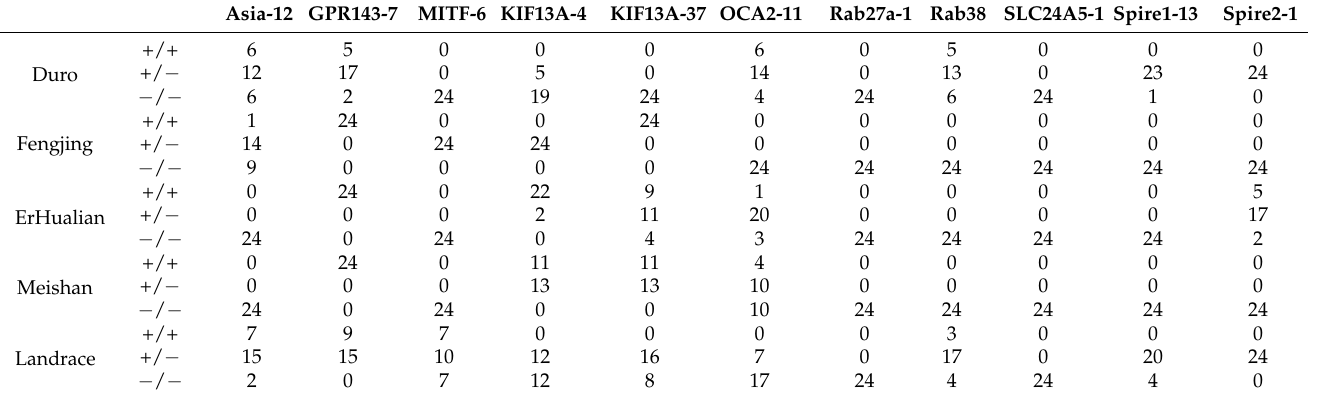
Table 3. The result of eleven RIPs detected in eleven breeds, transformed based on the gel